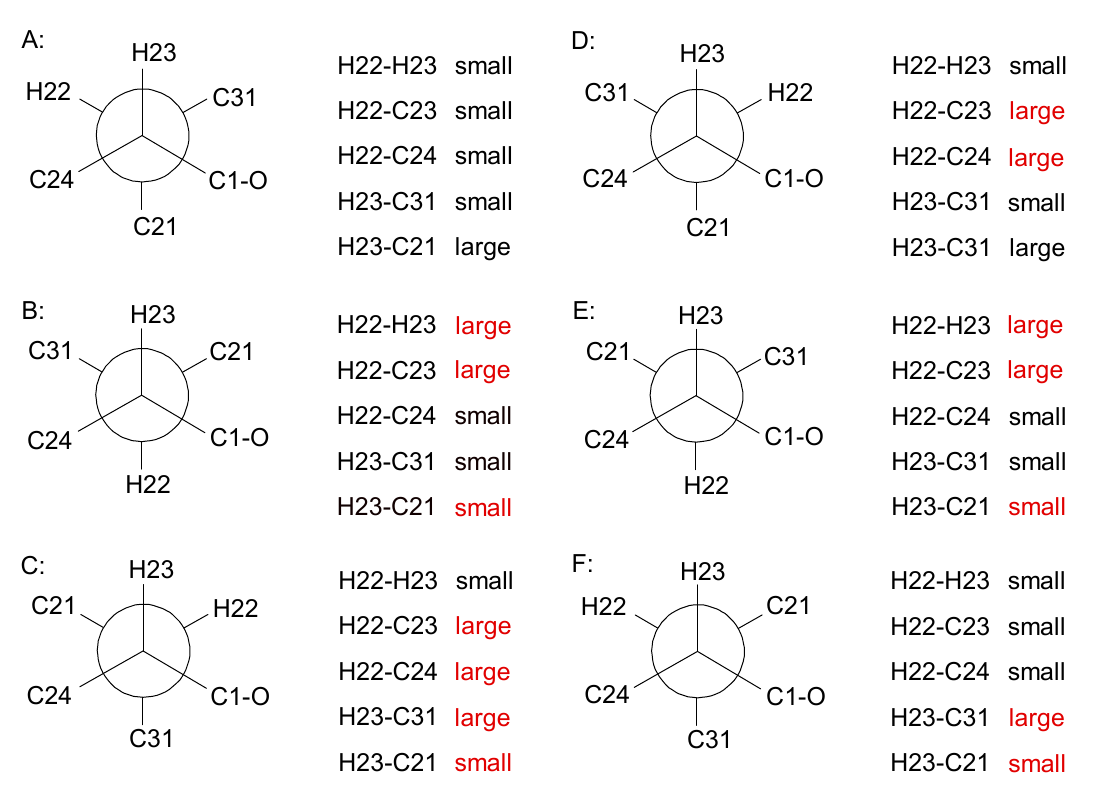
Figure 3. J-based analysis of six hypothetical rotamers with 22S,23S ( A – C ) and 22S,23R ( D – F ) configuration to determine the stereochemistry of 1 . Expected couplings contrary (shown in red) to the observed ones ( 3 J(H22,H23) = 4.8 Hz; 2 J(H22,C23) = 2.2 Hz; 3 J(H22,C24) = 1.0 Hz; 2 J(H23,C31) = 2.6 Hz; 3 J(H23,C21) = 6.6 Hz) exclude all configurations except A. This rotamer is confirmed by ROESY correlations between 23-H/22-H, 23-H/31-H 3 , 24-H a/b /22-H, and 31-H 3 /3-H b . Finally, the absolute configuration of the HMDA subunit was determined by the derivatization of the methanolysis product with S - and R -MTPA according to Mosher’s method. The pattern of ∆ δ SR values (see Figure 4) with negative values for 17-NH, 17-H, 18-H, 19-H 3 , 20-H 3 , and 31-H 3 , and positive ones for 24-H 2 to 29-H 2 , is diagnostic for a 23 R configuration [41].